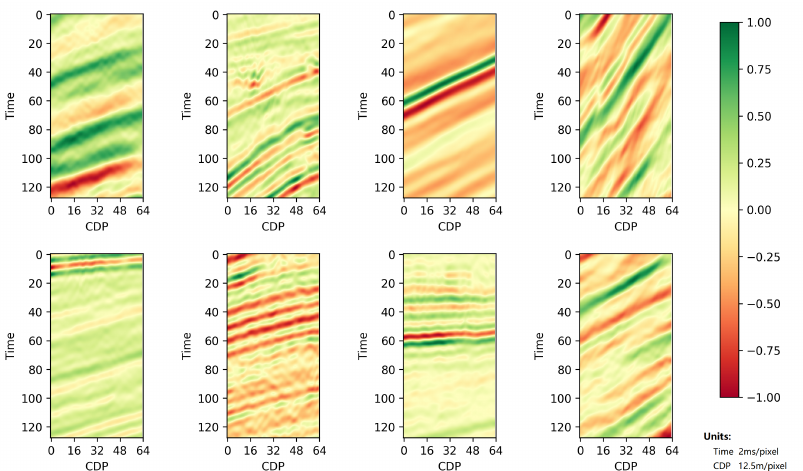
Figure 6. Input patches for training the network. Instead of the full image, small patches are used as the network input. Small images require small networks, which involve fewer parameters to tune and can easily converge in training. Furthermore, small networks have a higher generalization capacity. In addition, small patches cover various features, such as frequency appearance and dip angles.